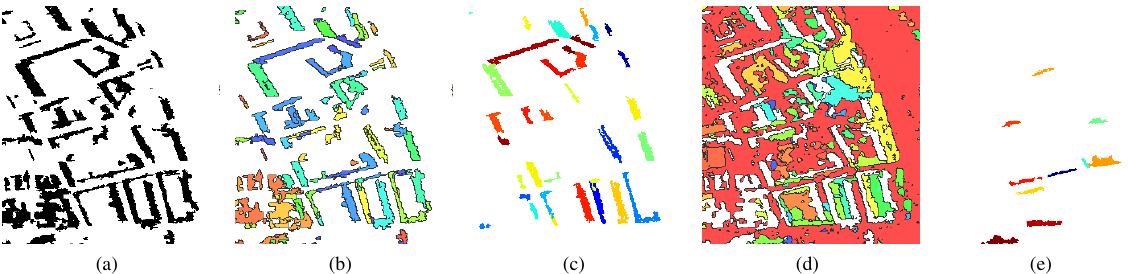
Figure 13: Outputs of the different stages of our method on a cropped area. (a) Pre-segmentation used to guide region growing. (b) Region growing and (c) final segmentation over high reflectivity areas. (d) Region growing and (e) final segmentation over low reflectivity areas.